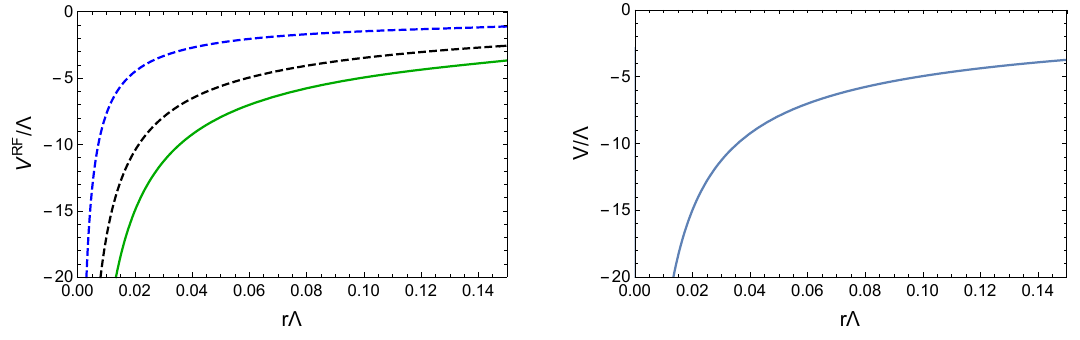
Figure 6 . Renormalon-free prediction V RF = (cid:3) V RF = (cid:3) (black dashed) and the (cid:14) part (blue dashed) are also shown separately. We also show disp MS the result obtained based on ref. [9]